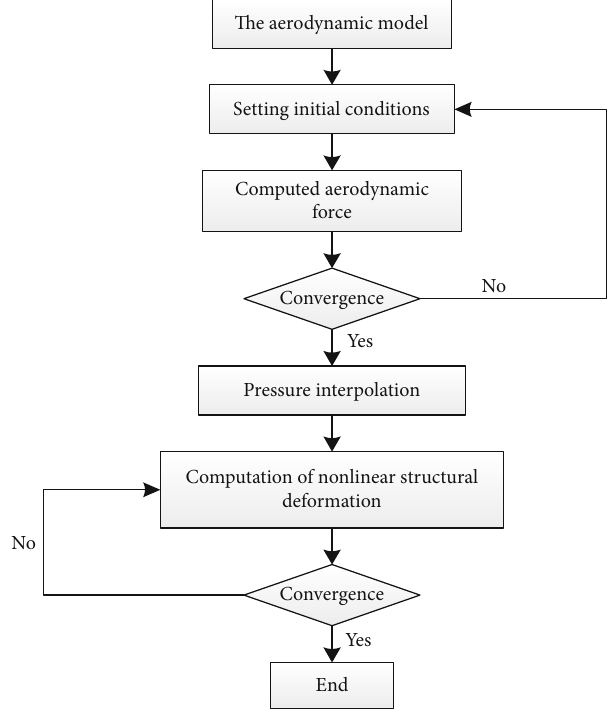
Figure 1: Calculation